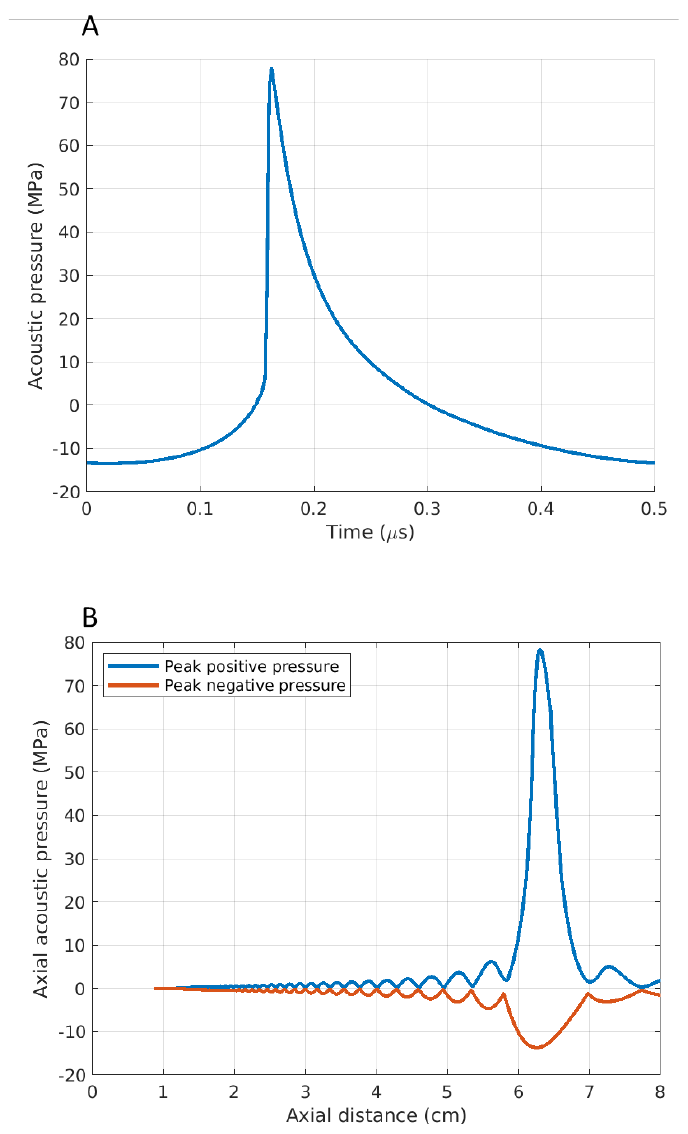
Figure 1. Simulated acoustic waveforms at ( A ) the HIFU focus on liver tissue and ( B ) axial pressure distribution.